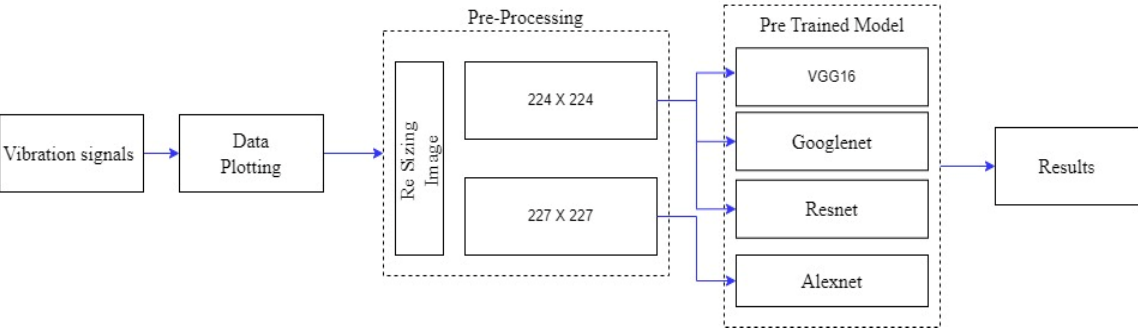
Figure 7. Overall method of TPMS using pretrained networks.